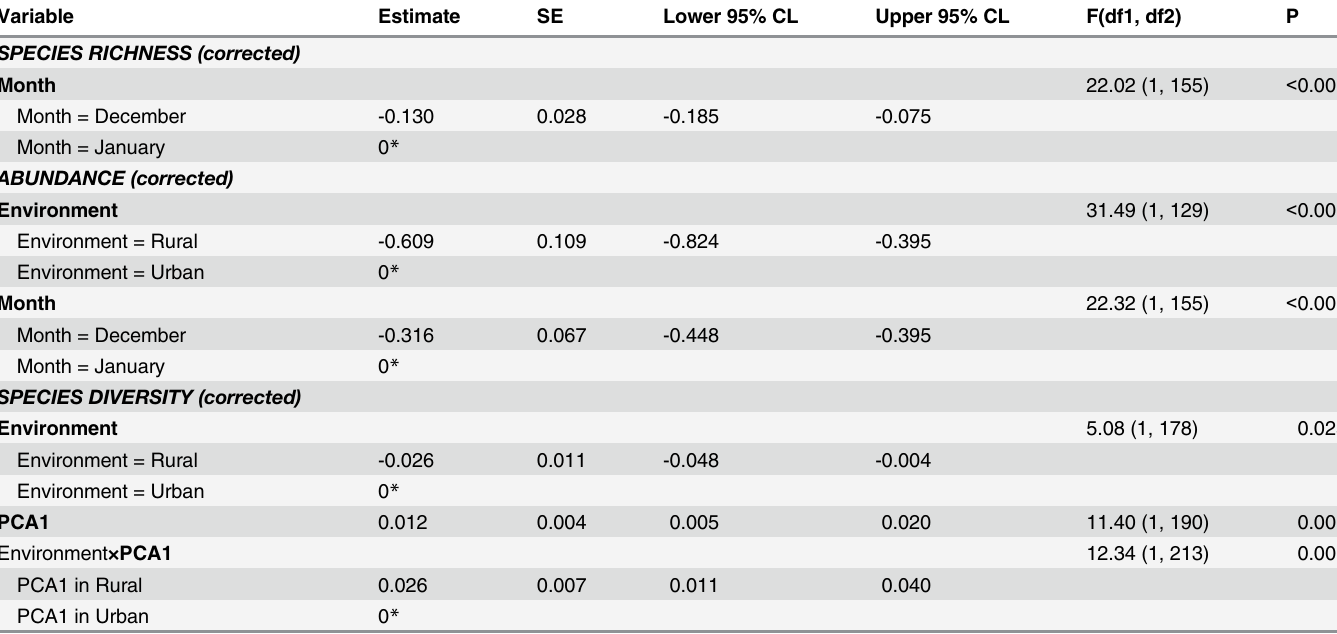
Table 3. Averaged estimates of the function slopes of variables present in the most parsimonious GLMMs describing the corrected species rich- ness, abundance and species diversity of birds in rural and urban areas during winter.